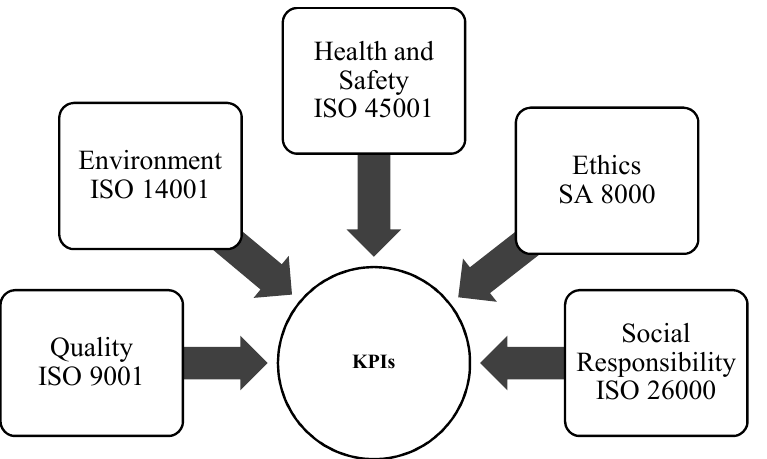
Figure 1. Integrated Management System scheme for defining Key Performance Indicators—KPIs.